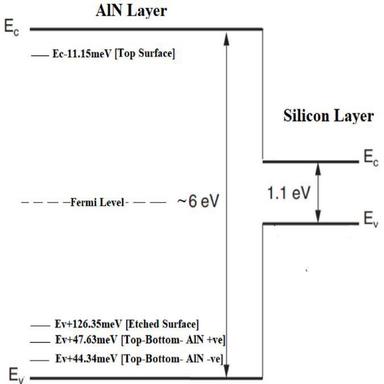
Band picture of AlN stack.